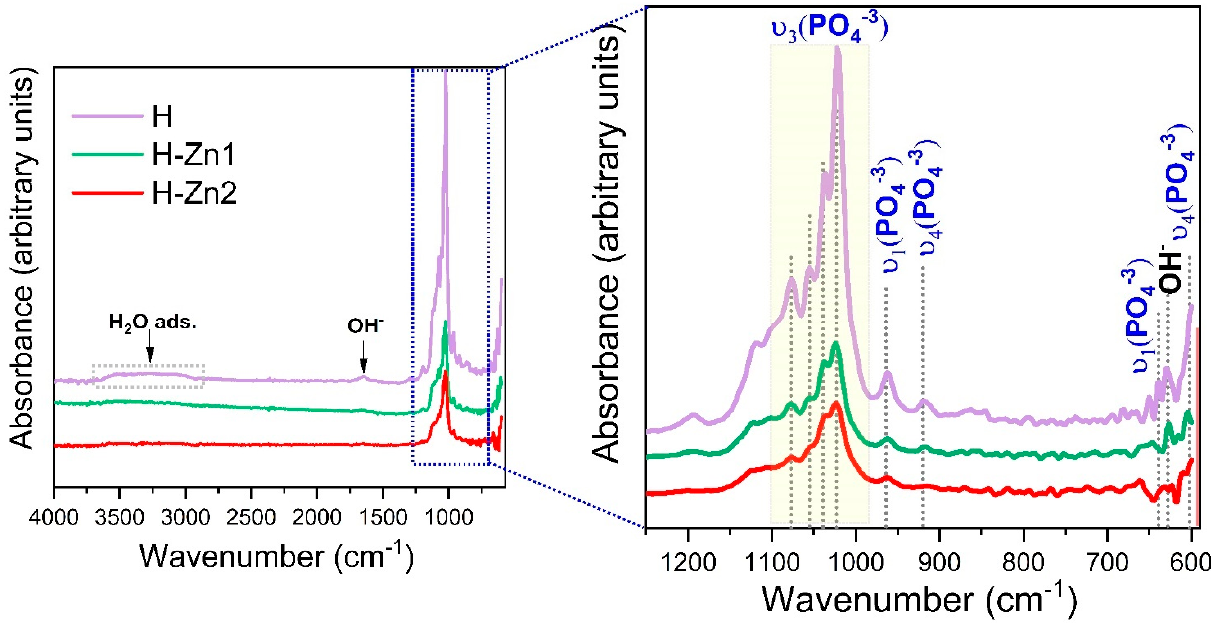
Figure 6. FTIR spectra of the undoped and Zn doped based coatings.